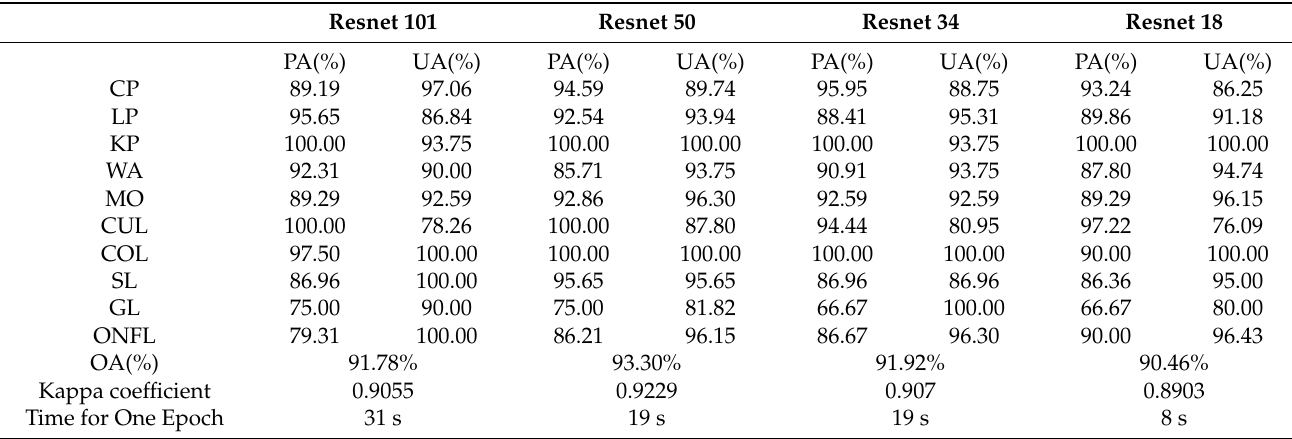
Table 5. Impact of the depth of residual network on classification accuracy. Resnet 101